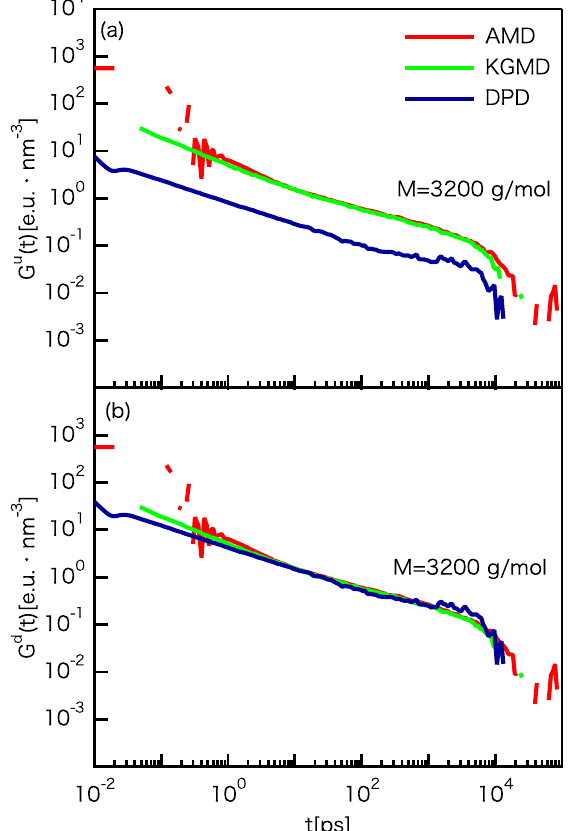
Figure 6. Comparison of G ( t ) for the UA PE model and rescaled CG models. ( a ) G ( t ) rescaled by the scaling factor of energy per volume ( ( k B T ) ∗ / l ∗ 3 ) based on the unit of the relaxation modulus. ( b ) G ( t ) using the scaling factor determined by Equation